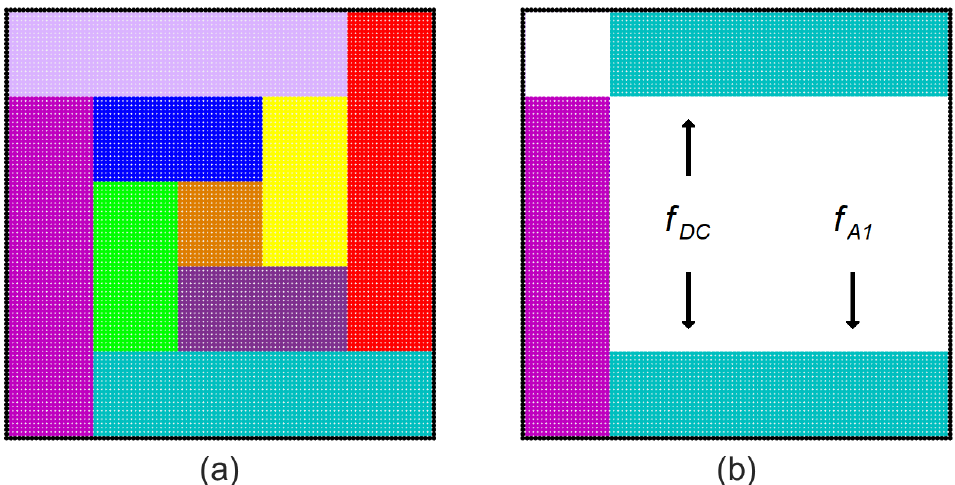
Figure 6. ( a ) One optimal solution for the objects used in the second study with restrained rotations. The objects perfectly fill the domain for optimal packing. ( b ) Demonstration of two possible positions for the placement of the second object during a sample run. For f DC metric both positions are equally preferable whereas the bottom location is more preferable for f A 1 .